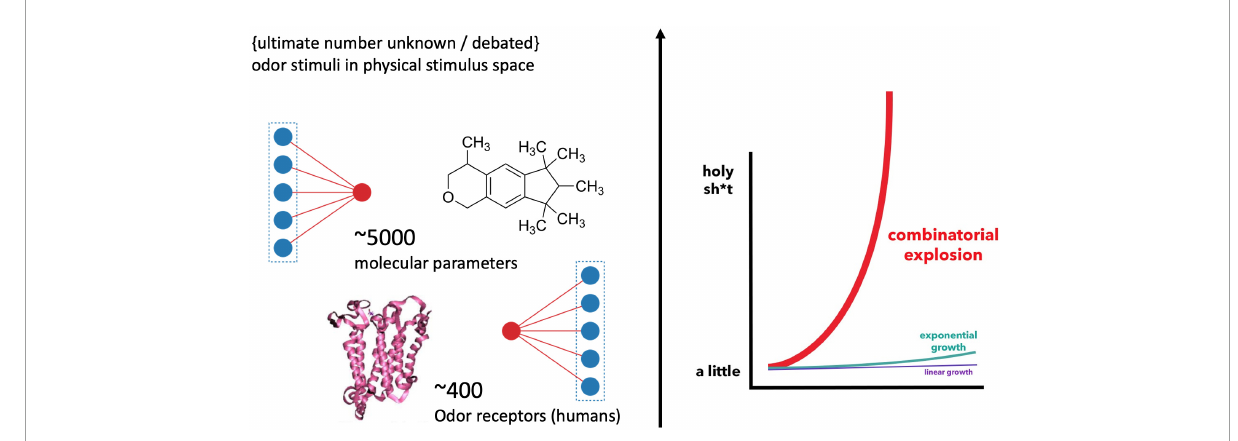
FIGURE1 Illustration of the “big data” challenge in modeling olfaction [Graph, right, by Bair (2015)]. Humans feature about 400 receptor genes. Each receptor interacts combinatorically with multiple physico-chemical properties of multiple odorants (Malnic et al., 1999) [The precise number of possible stimuli detected by the olfactory system is unknown and debated (Meister, 2015); while it is considered high (Ohloff et al., 2012)]. Additionally, there are several thousand possible parameters involved in odorant-receptor binding, resulting in an explosion of possible combinations for stimulus-receptor